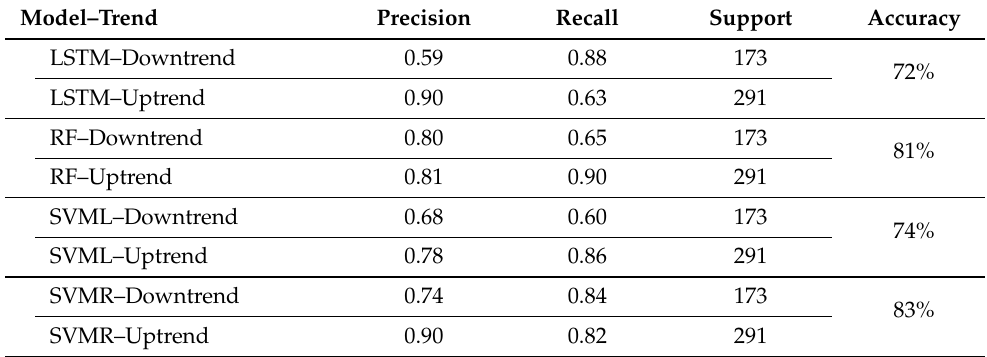
Table 3. Hit ratios of predictions to 63-days horizon.